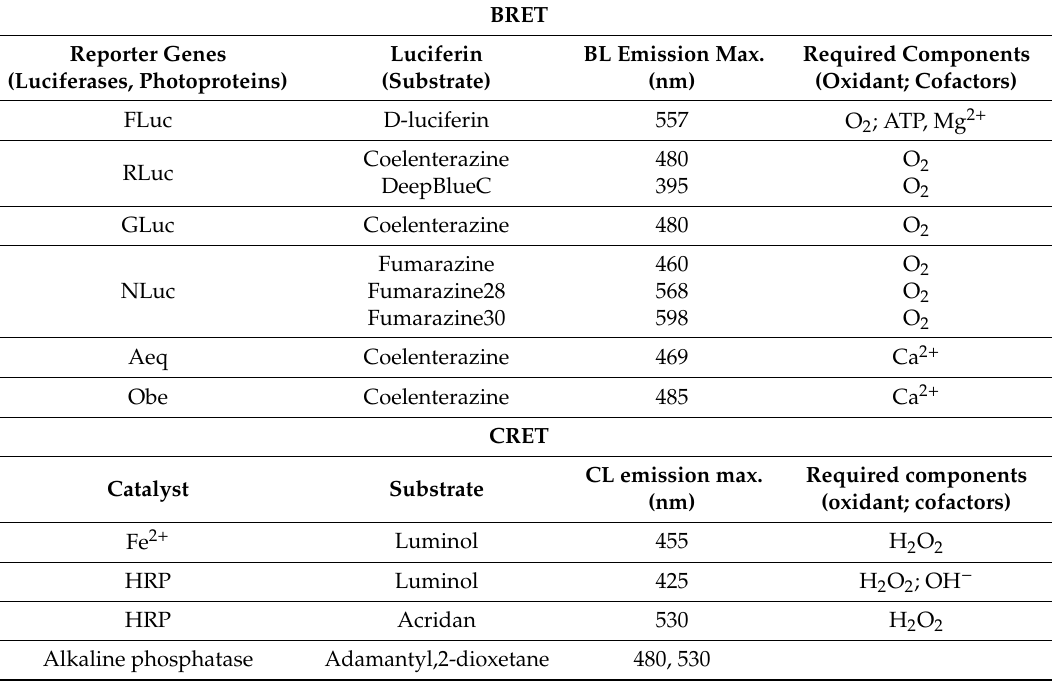
Table 1. Examples of BL and CL reporters used in BRET and CRET applications [20,22,28–30]